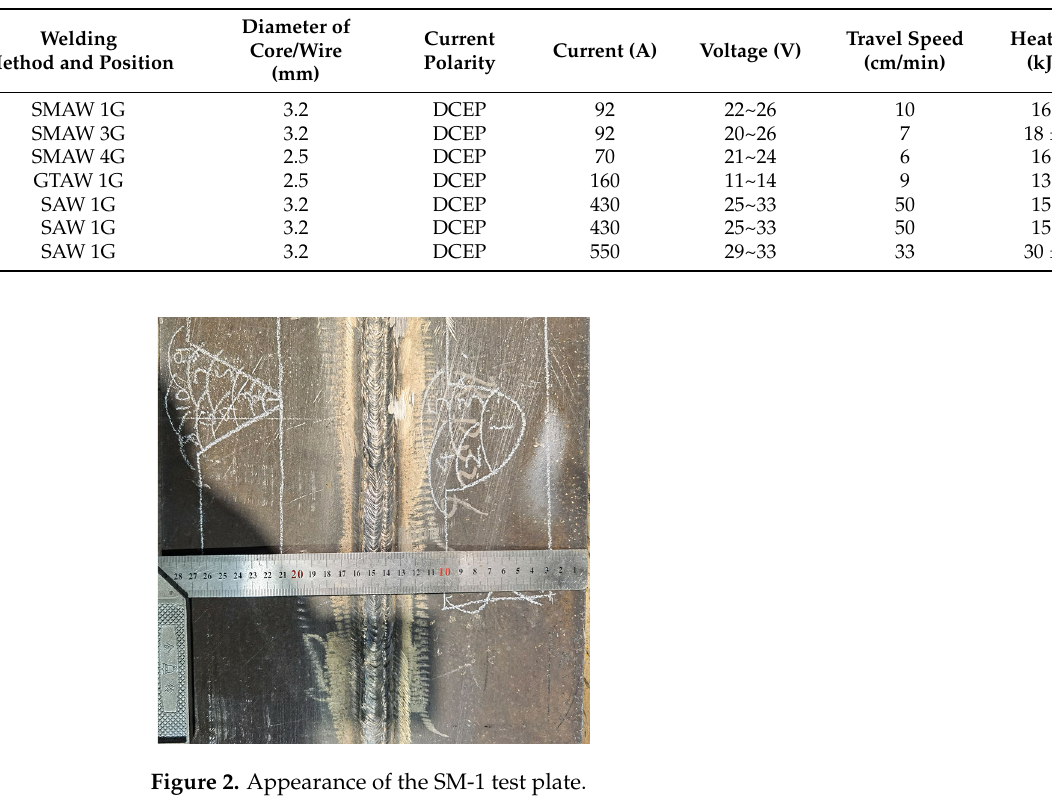
Table 4. Welding parameters.